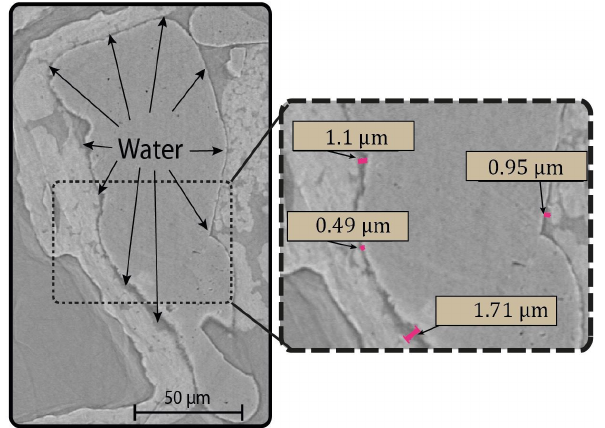
Figure 3. Raw (unfiltered) 2-D image in y , z direction at a spatial resolution of 0.38m. The zoom depicts the measurement of a thin interfacial water film varying in thickness from 0.49 to 1.71µm.